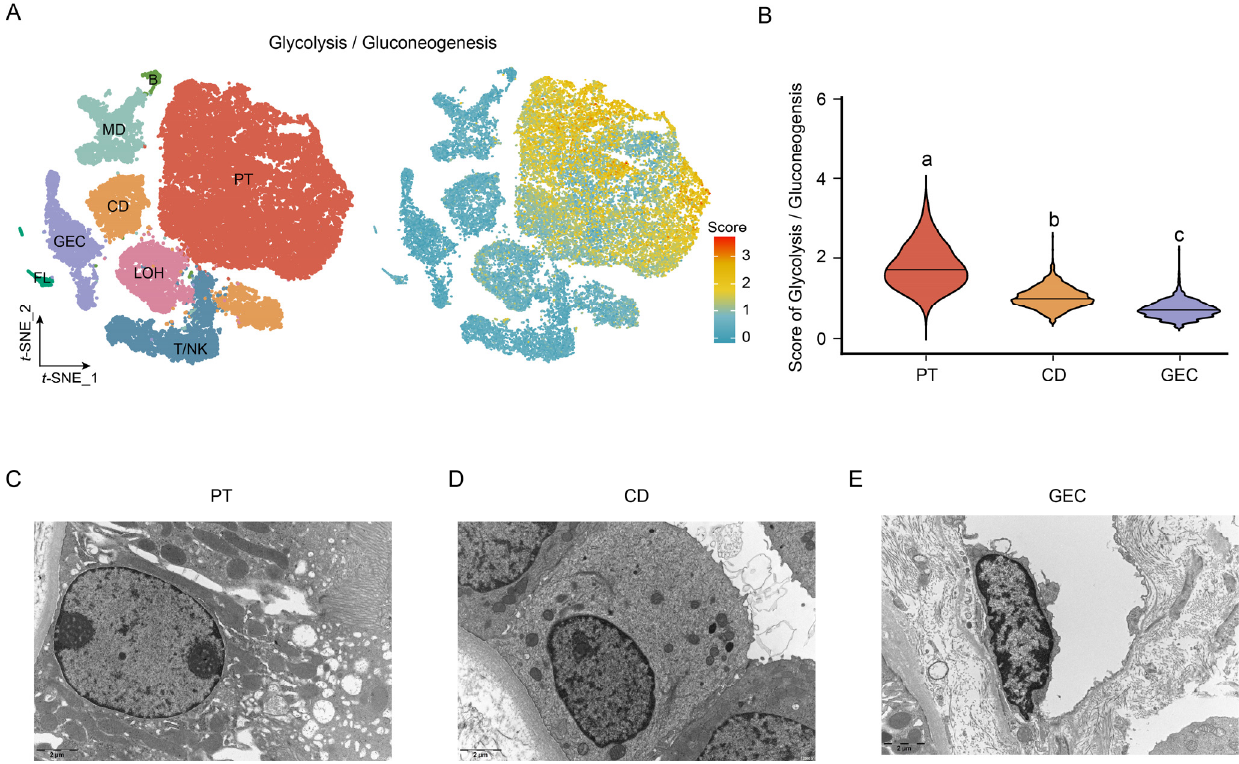
Figure 3. Comparison of the activity of glycolysis/gluconeogenesis among the normal renal cells. ( A ) The metabolic activity analysis of renal cells showed that PT had the highest glycolysis/gluconeogenesis metabolic activity in normal kidneys. ( B ) The violin plot showed the glycolysis/gluconeogenesis score among normal renal cells with Kruskal–Wallis H test. Significant differences among PT, CD, and GEC were denoted by different letters ( p < 0.05). Electron microscopy pictures of PT ( C ), CD ( D ), and GEC ( E ) showed that PT had higher numbers of organelles in the cytoplasm, more villi on the cell surface, rich euchromatin, and more distinct nucleolus than the CD and GEC.